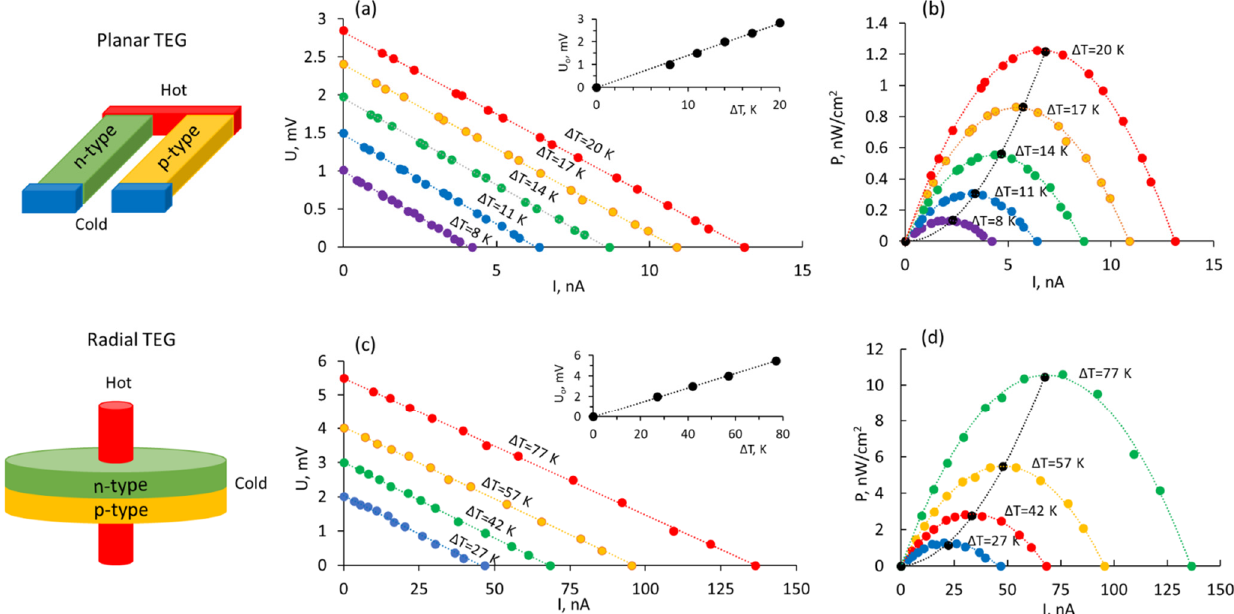
Figure 6. Characterization of load-dependent behavior of the PVA composites-based TEG prototypes: ( a , c ) output voltage vs. output current (insets—thermally generated open circuit voltage vs. applied temperature gradient); ( b , d ) output power per cross-section unit area vs. output current (black dots represent maximal power for each temperature gradient).